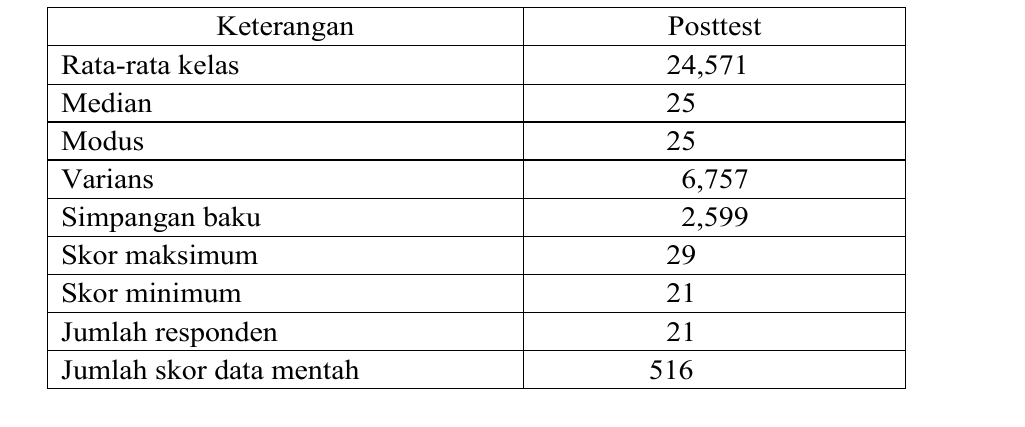
Tabel 2. Deskripsi Data Siklus